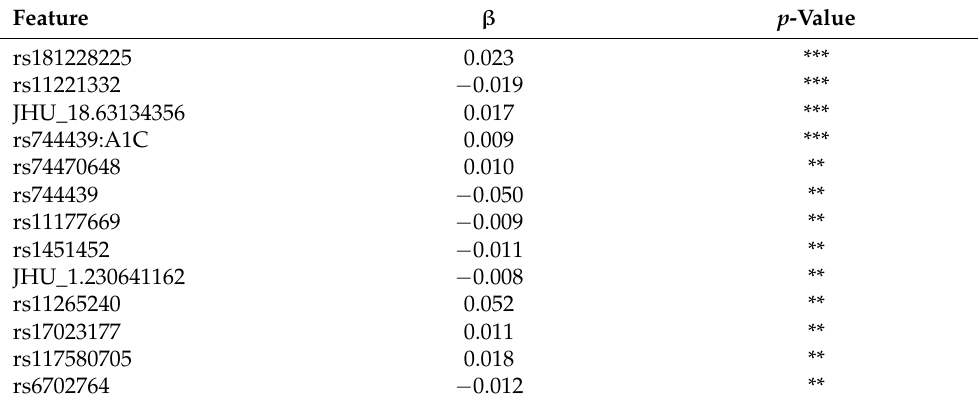
Table 9. Association estimates for features in final multivariate integrated additive and interactive genetic and HbA1c regression model for cg19693031